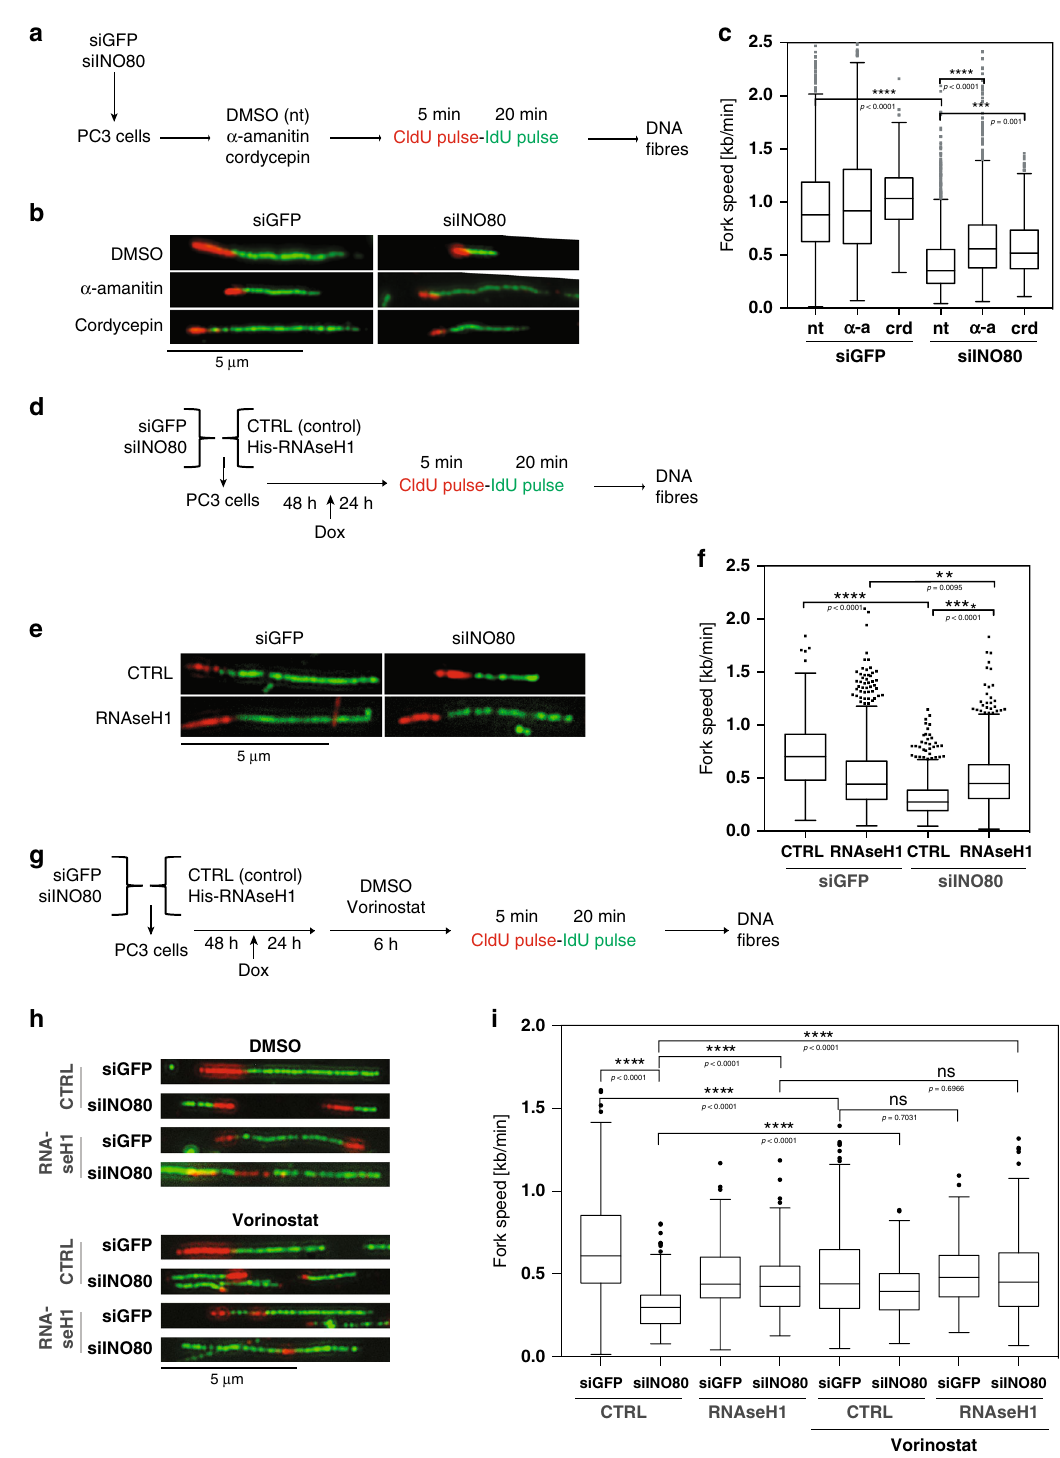
(Supplementary Fig. 4), ruling out the possibility that the repli- cation fork asymmetry in siINO80 cells is caused by DNA damage. When RNAse H1 was overexpressed in siINO80 cells, fork symmetry was recovered (Fig. 2), strongly suggesting that R- loops cause increased replication fork stalling in the absence of INO80. RNAse H1 reduces DNA damage in replicating siINO80 cells . Collisions between replication forks and R-loops induce